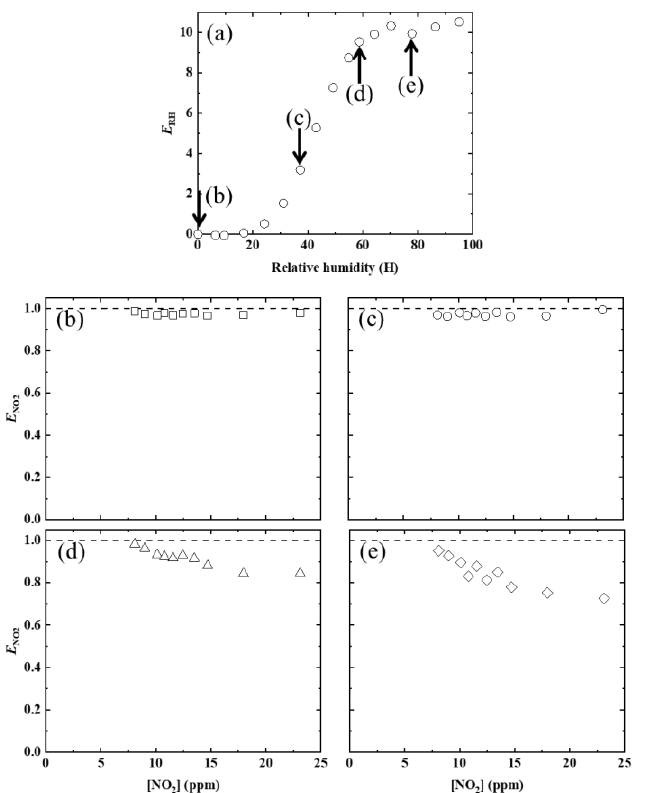
Figure 5. ( a ) Dependence of E RH on RH, at room temperature. Dependence of E NO2 on [NO 2 ], at various RH values (RH = 0.1 ( b ), 37 ( c ), 59 ( d ), and 78 ( e )%). various RH values (RH = 0.1 ( b ), 37 ( c ), 59 ( d ), and 78 ( e